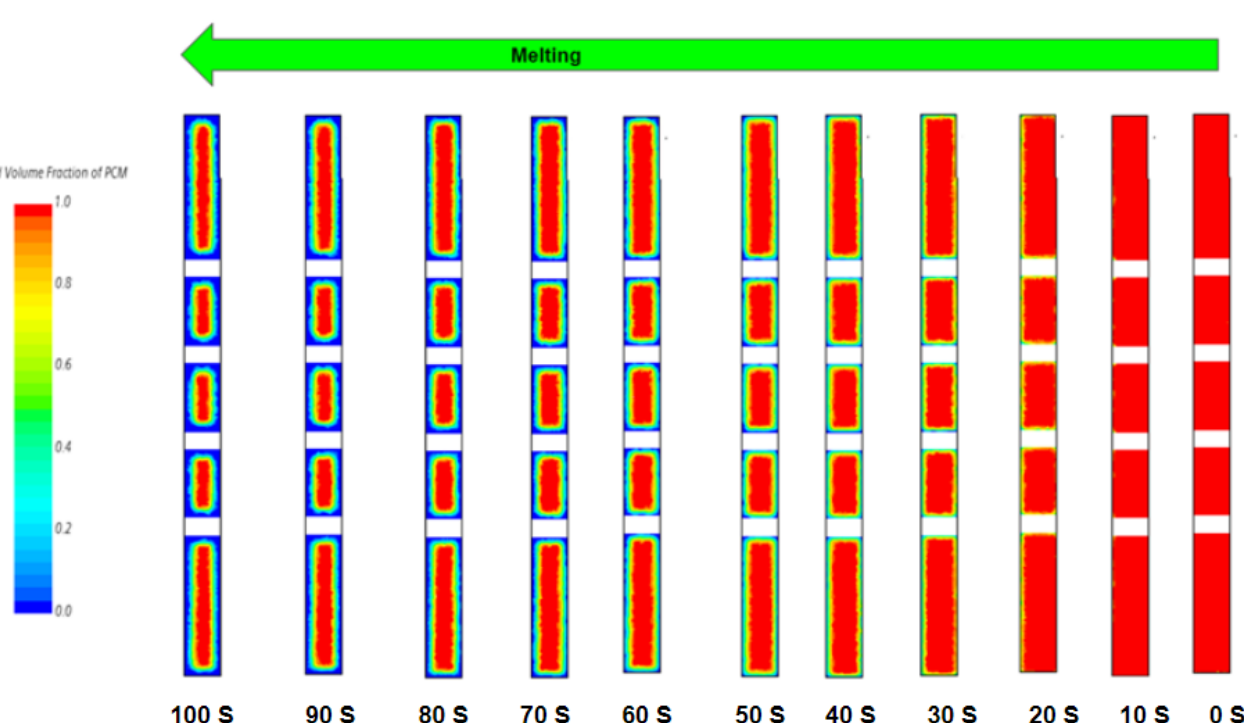
Figure 12. The volume change with function of time for two rib configuration.